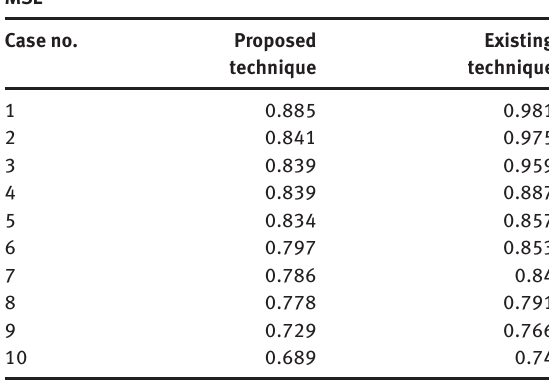
Table 2: Tabulation for MSE. MSE Case